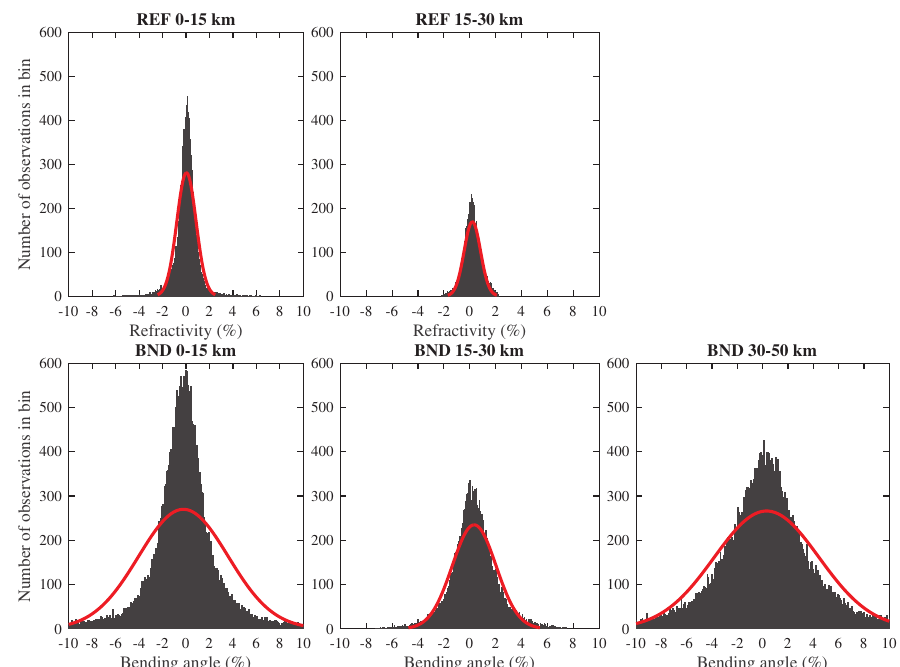
Figure 2. Frequency histograms of the differences between the observations and background by height intervals, in the REF ( upper panels) and BND ( lower panels) experiments, referring to the analysis generated on 10 August 2014 at 1200 UTC. Red curves represent the normal distribution fit curve in each height